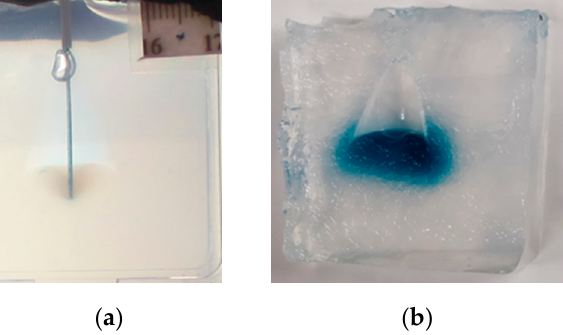
Figure 5. ( a ) Image of clogged continuously deploying catheter after 100 min of infusion. ( b ) Cross-sectional image of the same infusion after catheter removal.